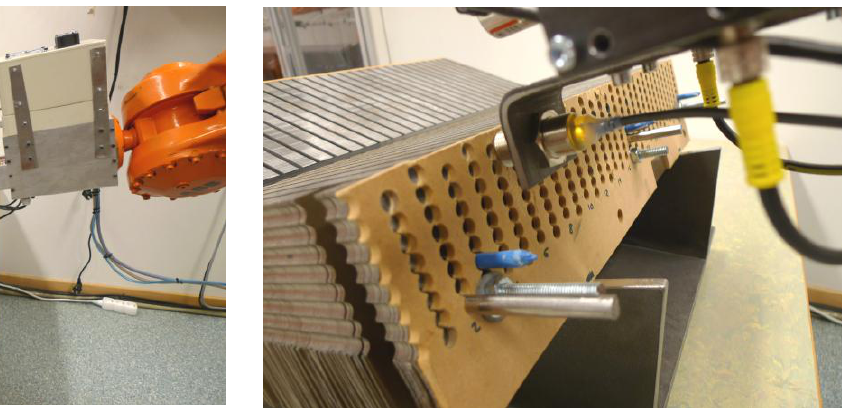
Figure 6. ( a ) The proximity sensor mounted on top of the cable feeder tool is used to measure the position of the stator section surface in one point. ( b ) A close-up of the robot-held proximity sensor while used to measure the position of the stator section over a stator